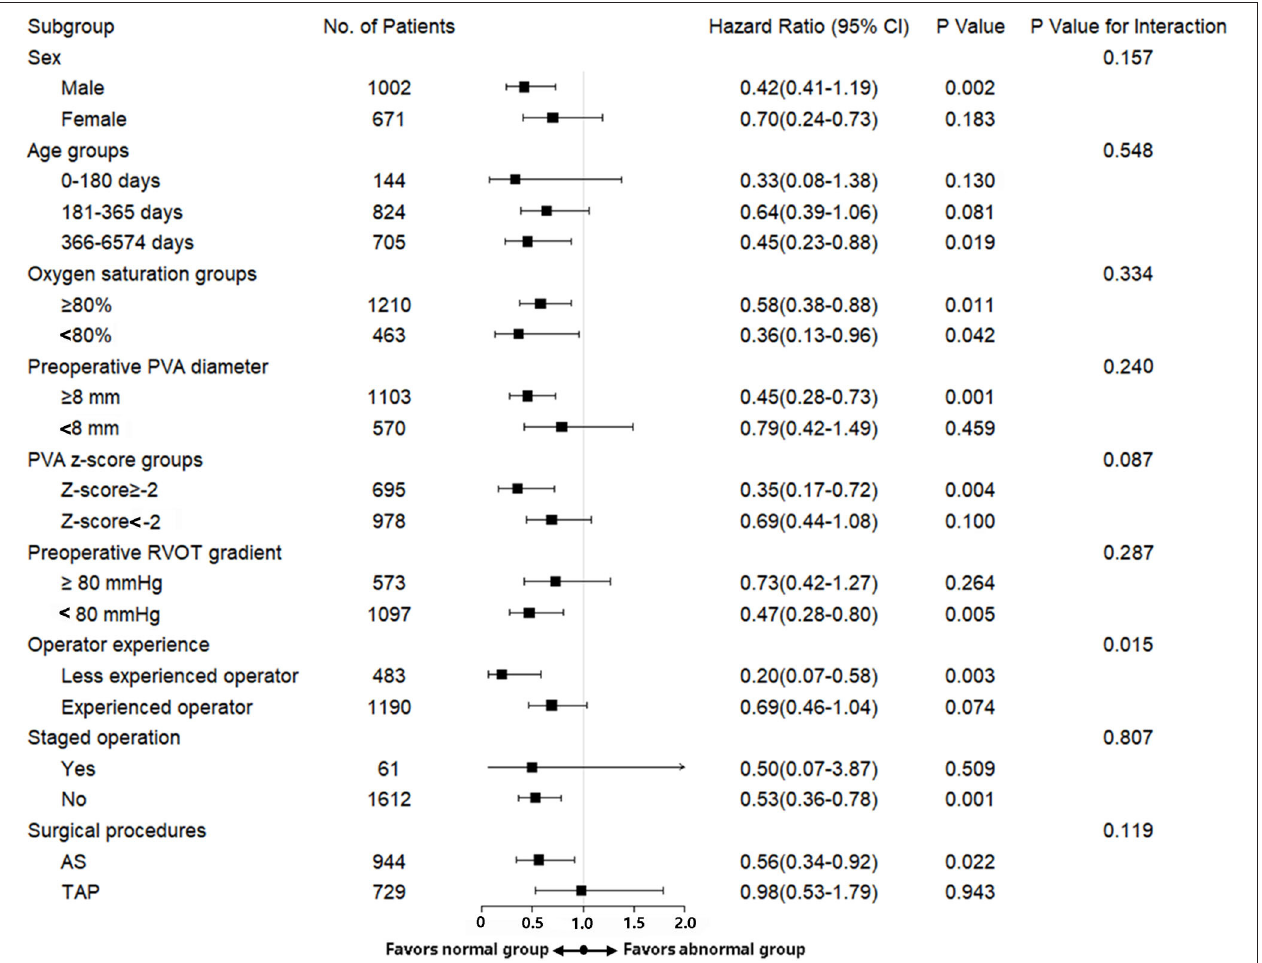
FIGURE 2 | Multivariable Cox regression results between normal pulmonary valve morphology and abnormal pulmonary valve morphology for the composite primary end point among patient subgroups. Multivariable Cox regression results for a composite end point of reintervention and PV-TPS in Class 3 at follow up among patient subgroups including different sex groups, age groups, PVA z-score groups, PVAD groups, and whether AS was used and whether staged operation was